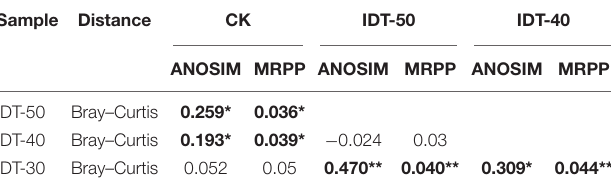
TABLE 6 | Significance tests on the effects of different tillage methods on the rhizosphere bacterial functional profiles. Sample